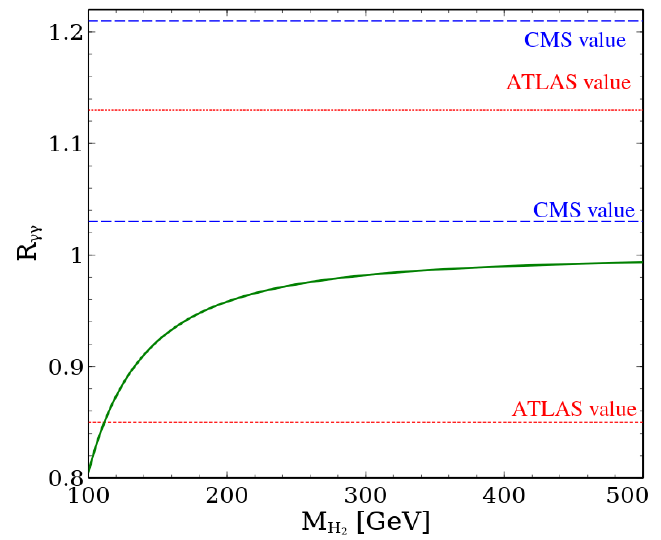
Figure 26 . Higgs diphoton Rate for different masses of H 2 assuming sin α = sin δ = 0 . 1